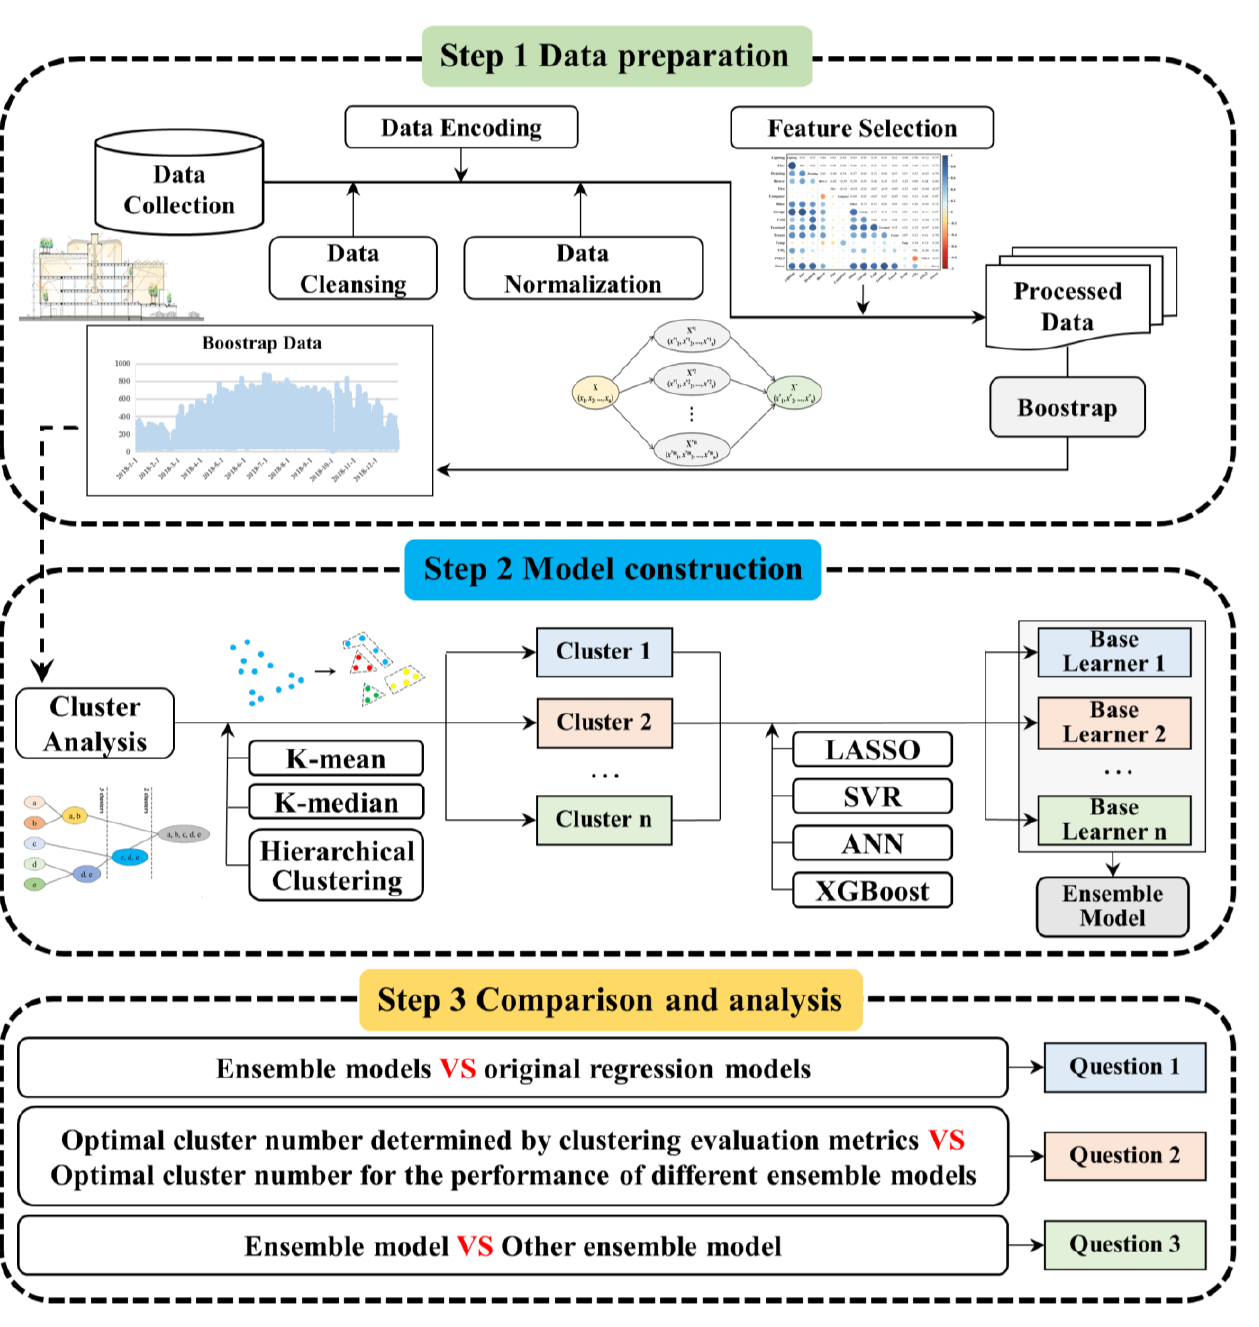
Figure 1. Research outline of the